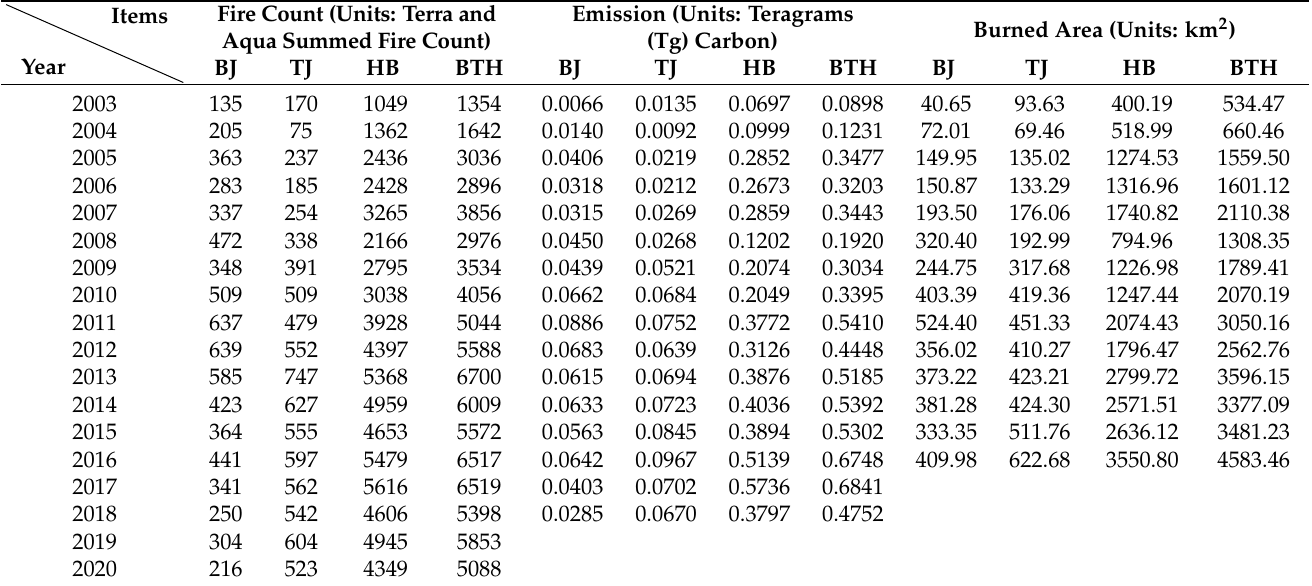
Table 1. A dataset of fire counts, carbon emissions, and burning area from 2003 to 2020 in different provinces in